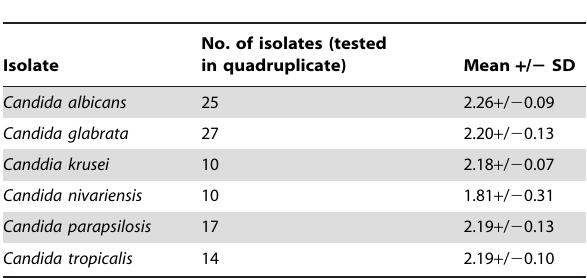
Table 3. Variations of the match score values generated by the Biotyper system for selected Candida